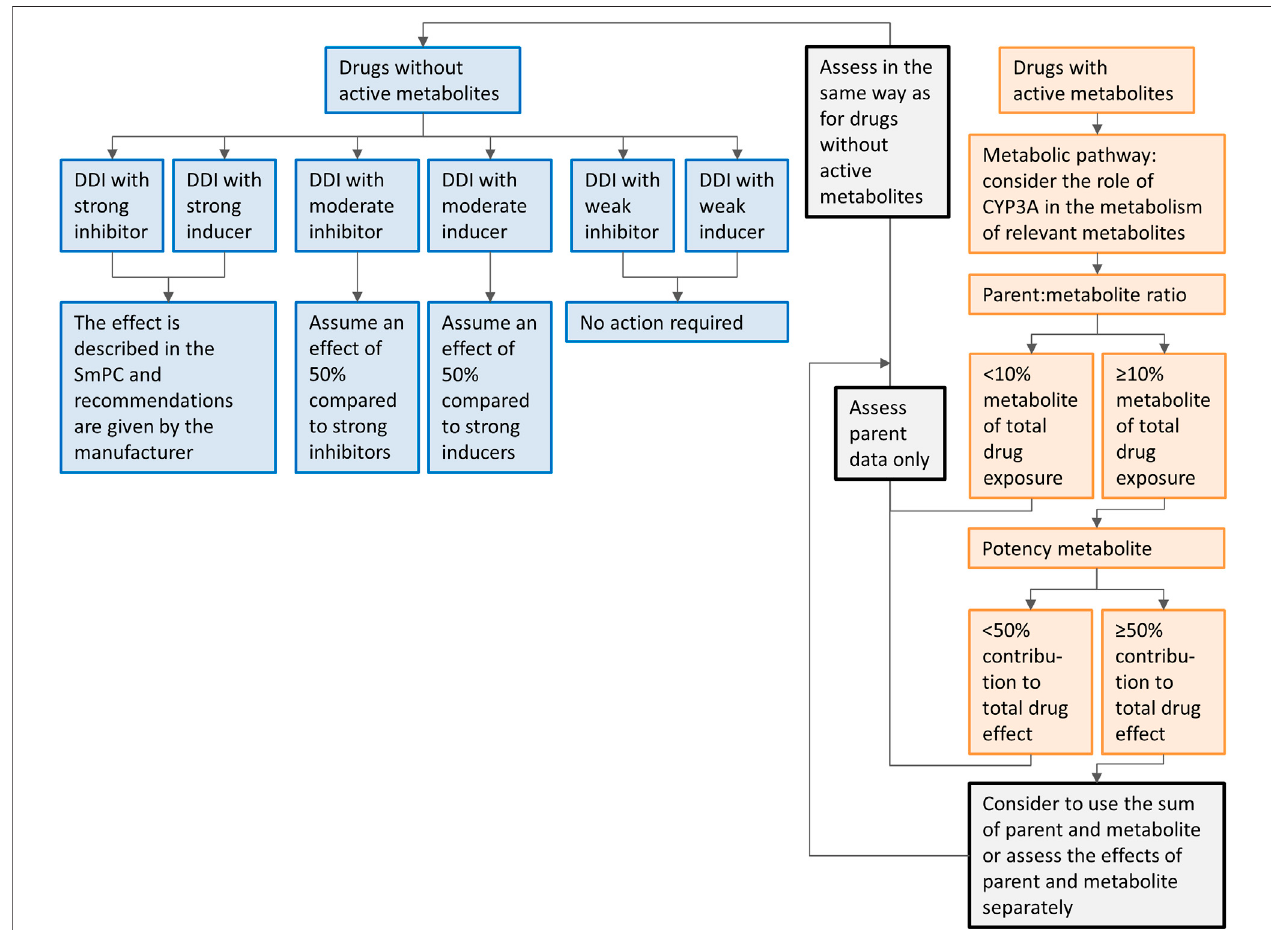
FIGURE 5 | Flowchart of the recommendations on how to handle DDIs for oral anticancer drugs metabolized by CYP3A if only clinical data from strong CYP3A inhibitorsorinducersisavailable. Cautionshouldbe takenwhileusing the fl owchartfordrugs inwhichauto-induction or-inhibitionplays aroleand drug-drug interaction studies are not performed on steady-state, or for drugs with nonlinear dose-exposure